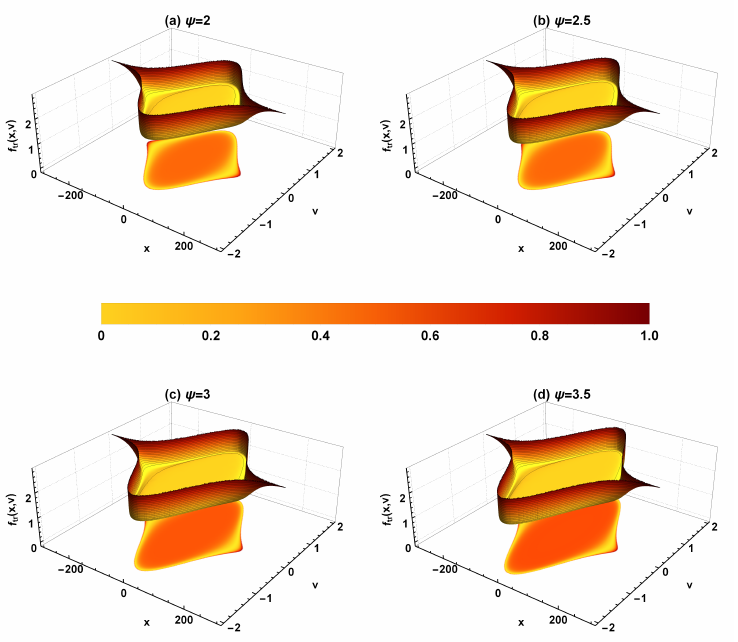
Figure 8. The same as Figure 7, except that the choice of ψ and δ designate Region 2. For each panel, a small hump at the center of the phase space distribution can be